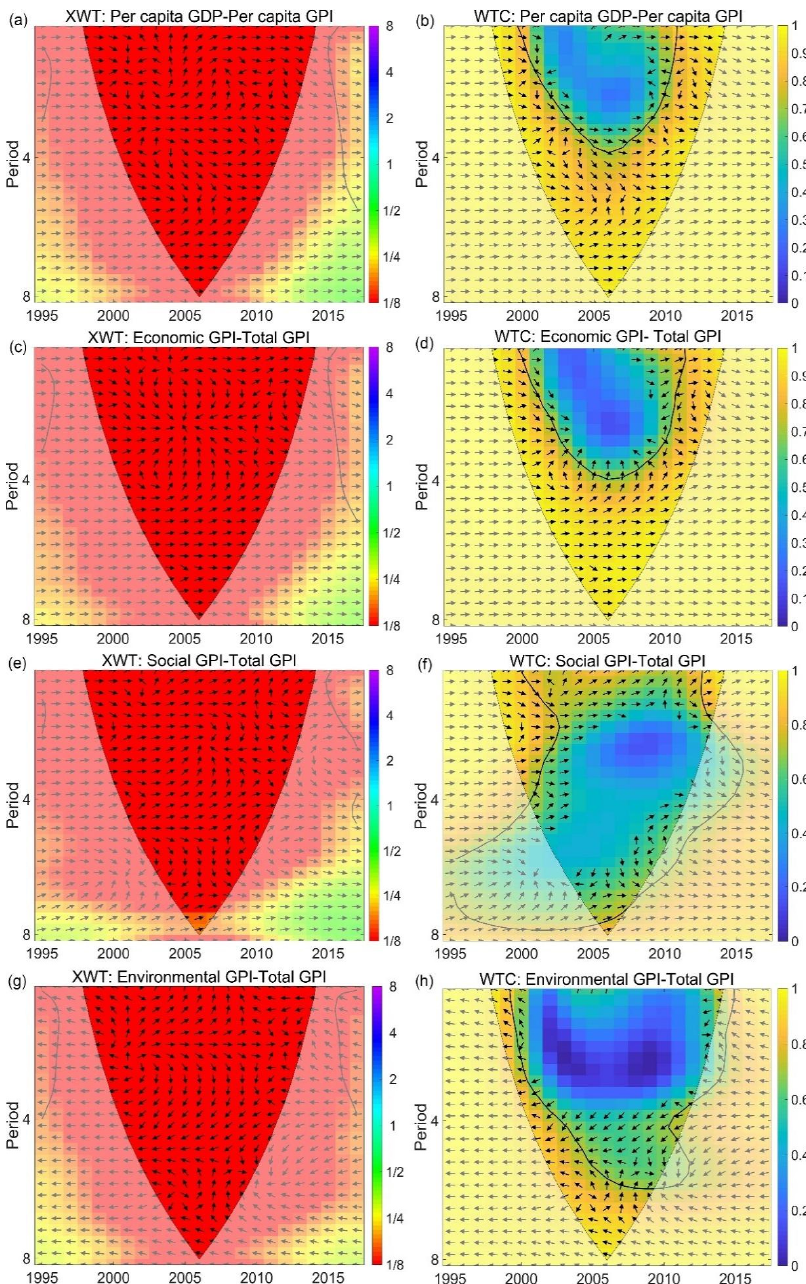
Figure 3. Wavelet power spectrum ( a , c , e , g ) and wavelet condensation spectrum of primary variables (per capita GPI and total GPI; and per capita GPI, economic GPI, social GPI, and environmental GPI) ( b , d , f , h ). The thick black contour designates the 5% significance level for red noise, and the cone of influence (COI) where edge effects might distort the picture is shown by a lighter shade. Phase change reflects the difference in response time of primary variables to influence factors. The phase relationship between influence factors and primary variables is indicated by arrows. The arrows from left to right indicate that the influencing factors and primary variables are in the same phase, which implies a positive correlation; the arrows from right to left indicate an inverse phase, which implies a negative correlation; the downward arrows indicate that influencing factors are 90 ◦ ahead of primary variables, and the upward arrows indicate that influence factors are 90 ◦ behind primary